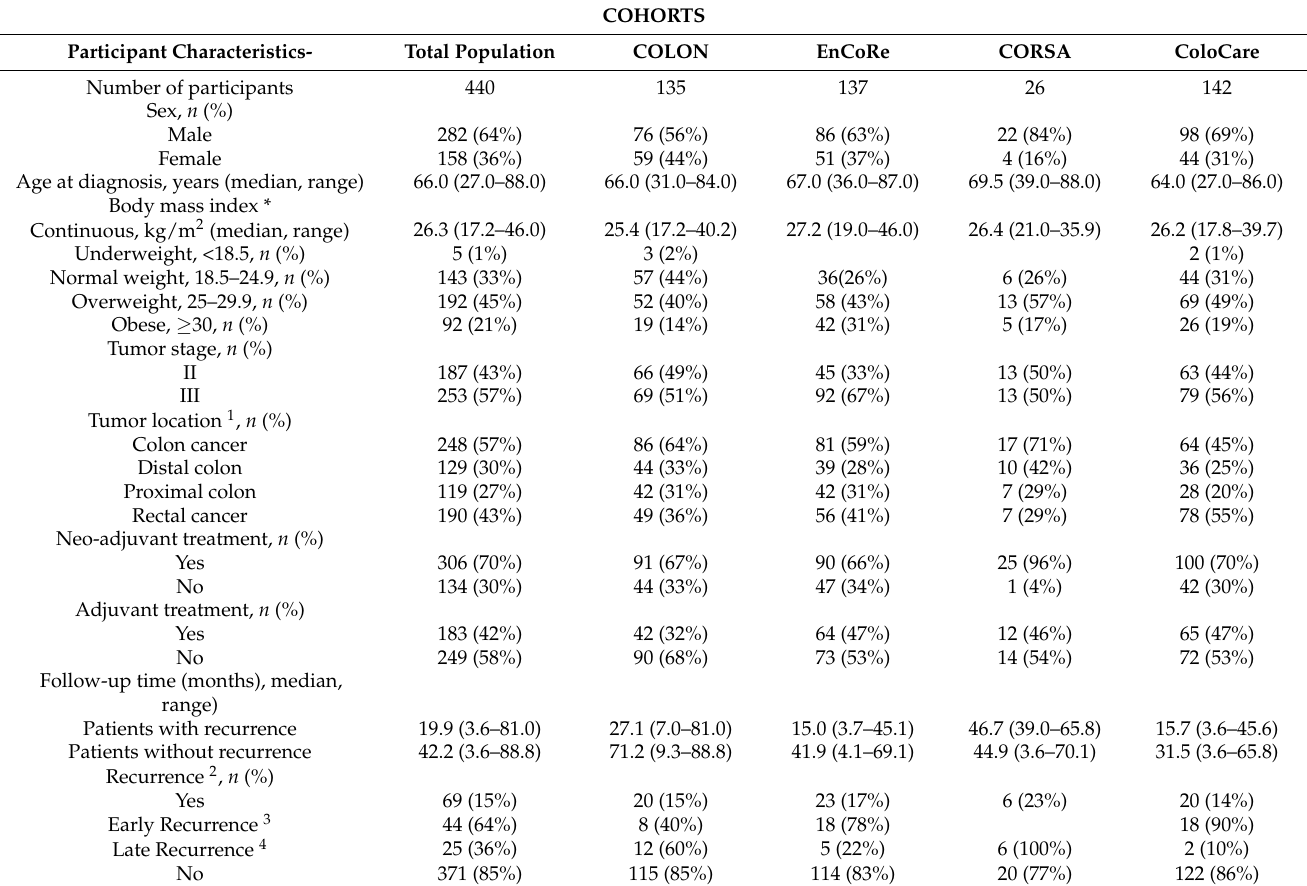
Table 1. Baseline characteristics of the overall study population and by